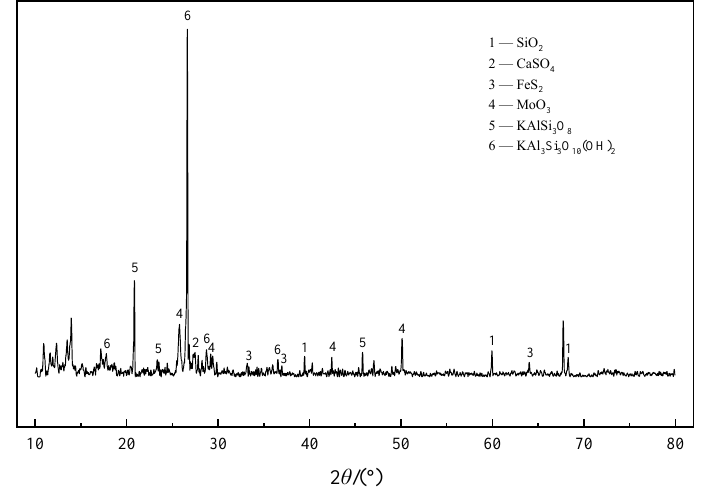
Figure 9. XRD analysis of ammonia leaching residue.